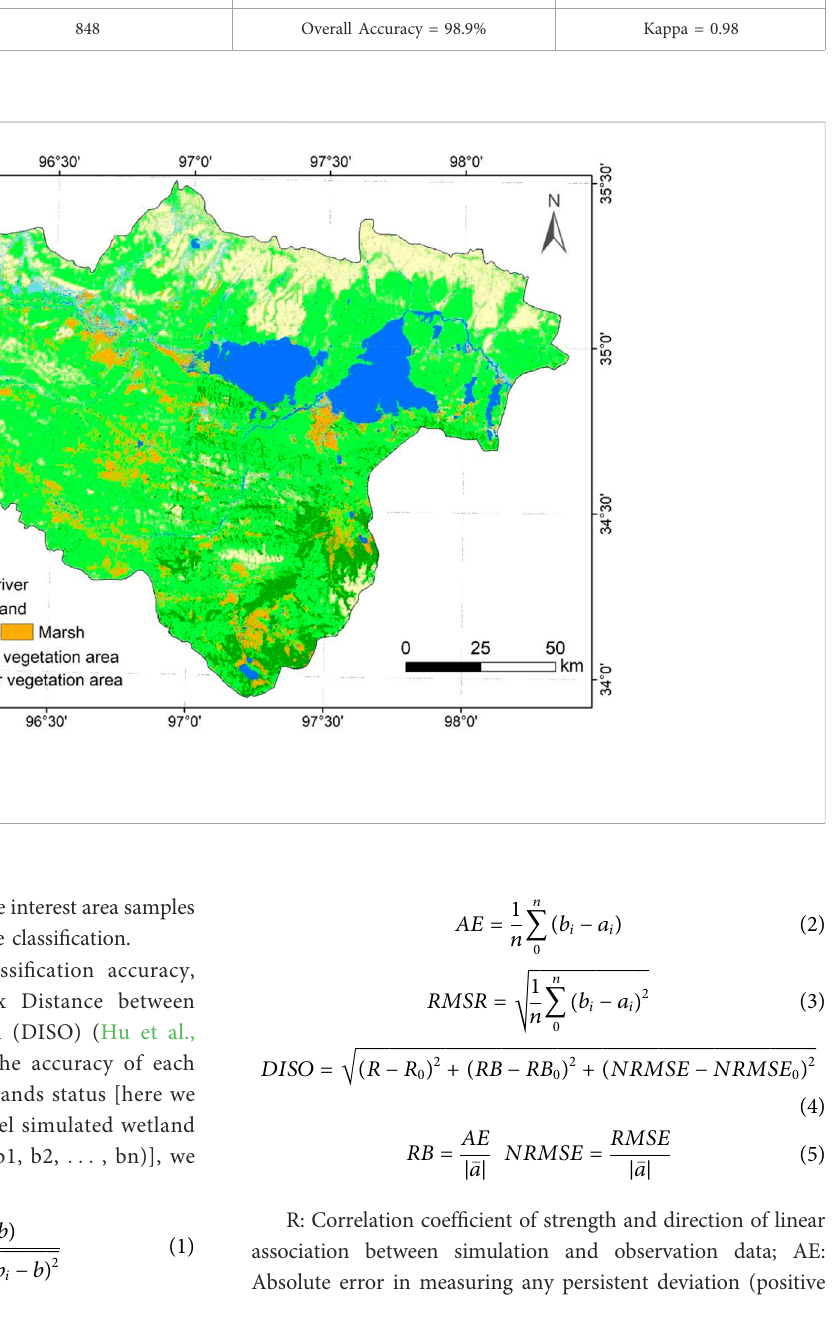
R: Correlation coef fi cient of strength and direction of linear association between simulation and observation data; AE: Absolute error in measuring any persistent deviation (positive